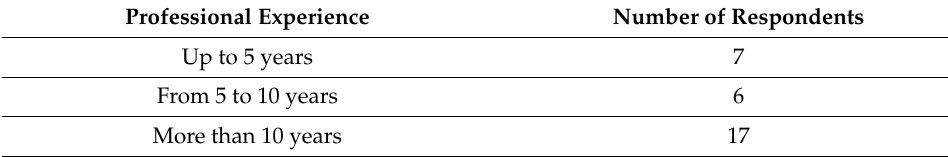
Table 3. Length of professional experience.